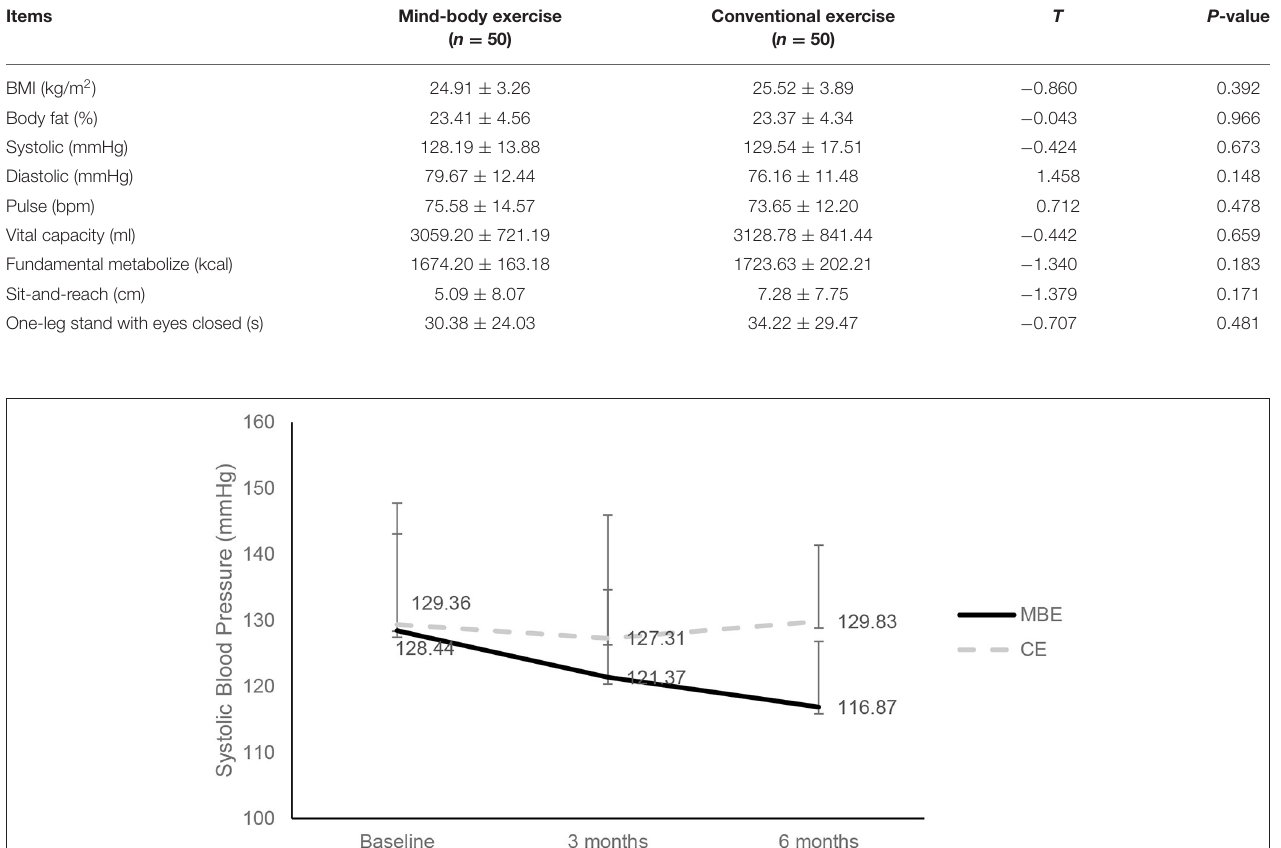
FIGURE 2 | Comparison of systolic blood pressure between the two groups at the different phases (unit: mmHg). MBE, mind-body exercise group; CE, conventional exercise